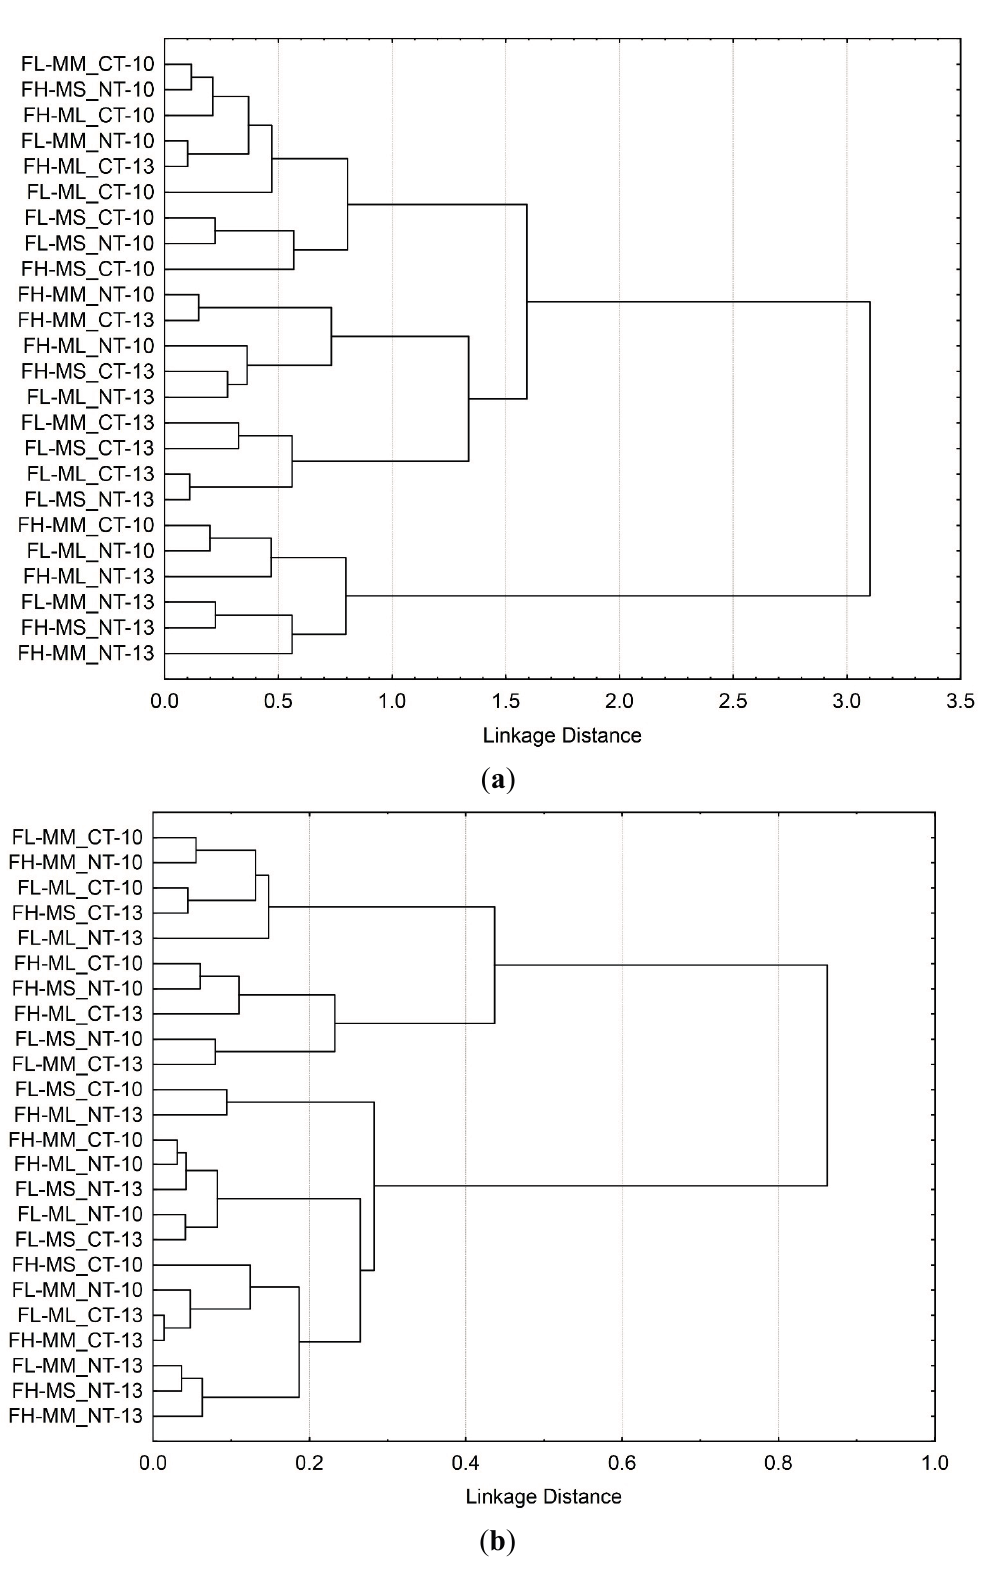
Figure 2. ( a ) Cluster analysis comparing the influence of different CA practices on soil microbial species richness (Shannon–Weaver Index) during the 2009/2010 and 2012/2013 planting seasons. ( b ) Cluster analysis comparing the influence of different CA practices on soil microbial species abundance (Evenness Index) during the 2009/2010 and 2012/2013 planting